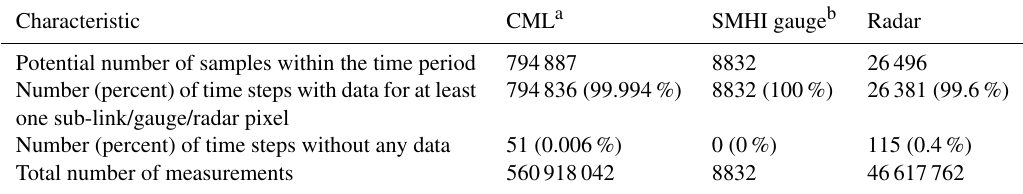
Table 4. Overview of data collection results.